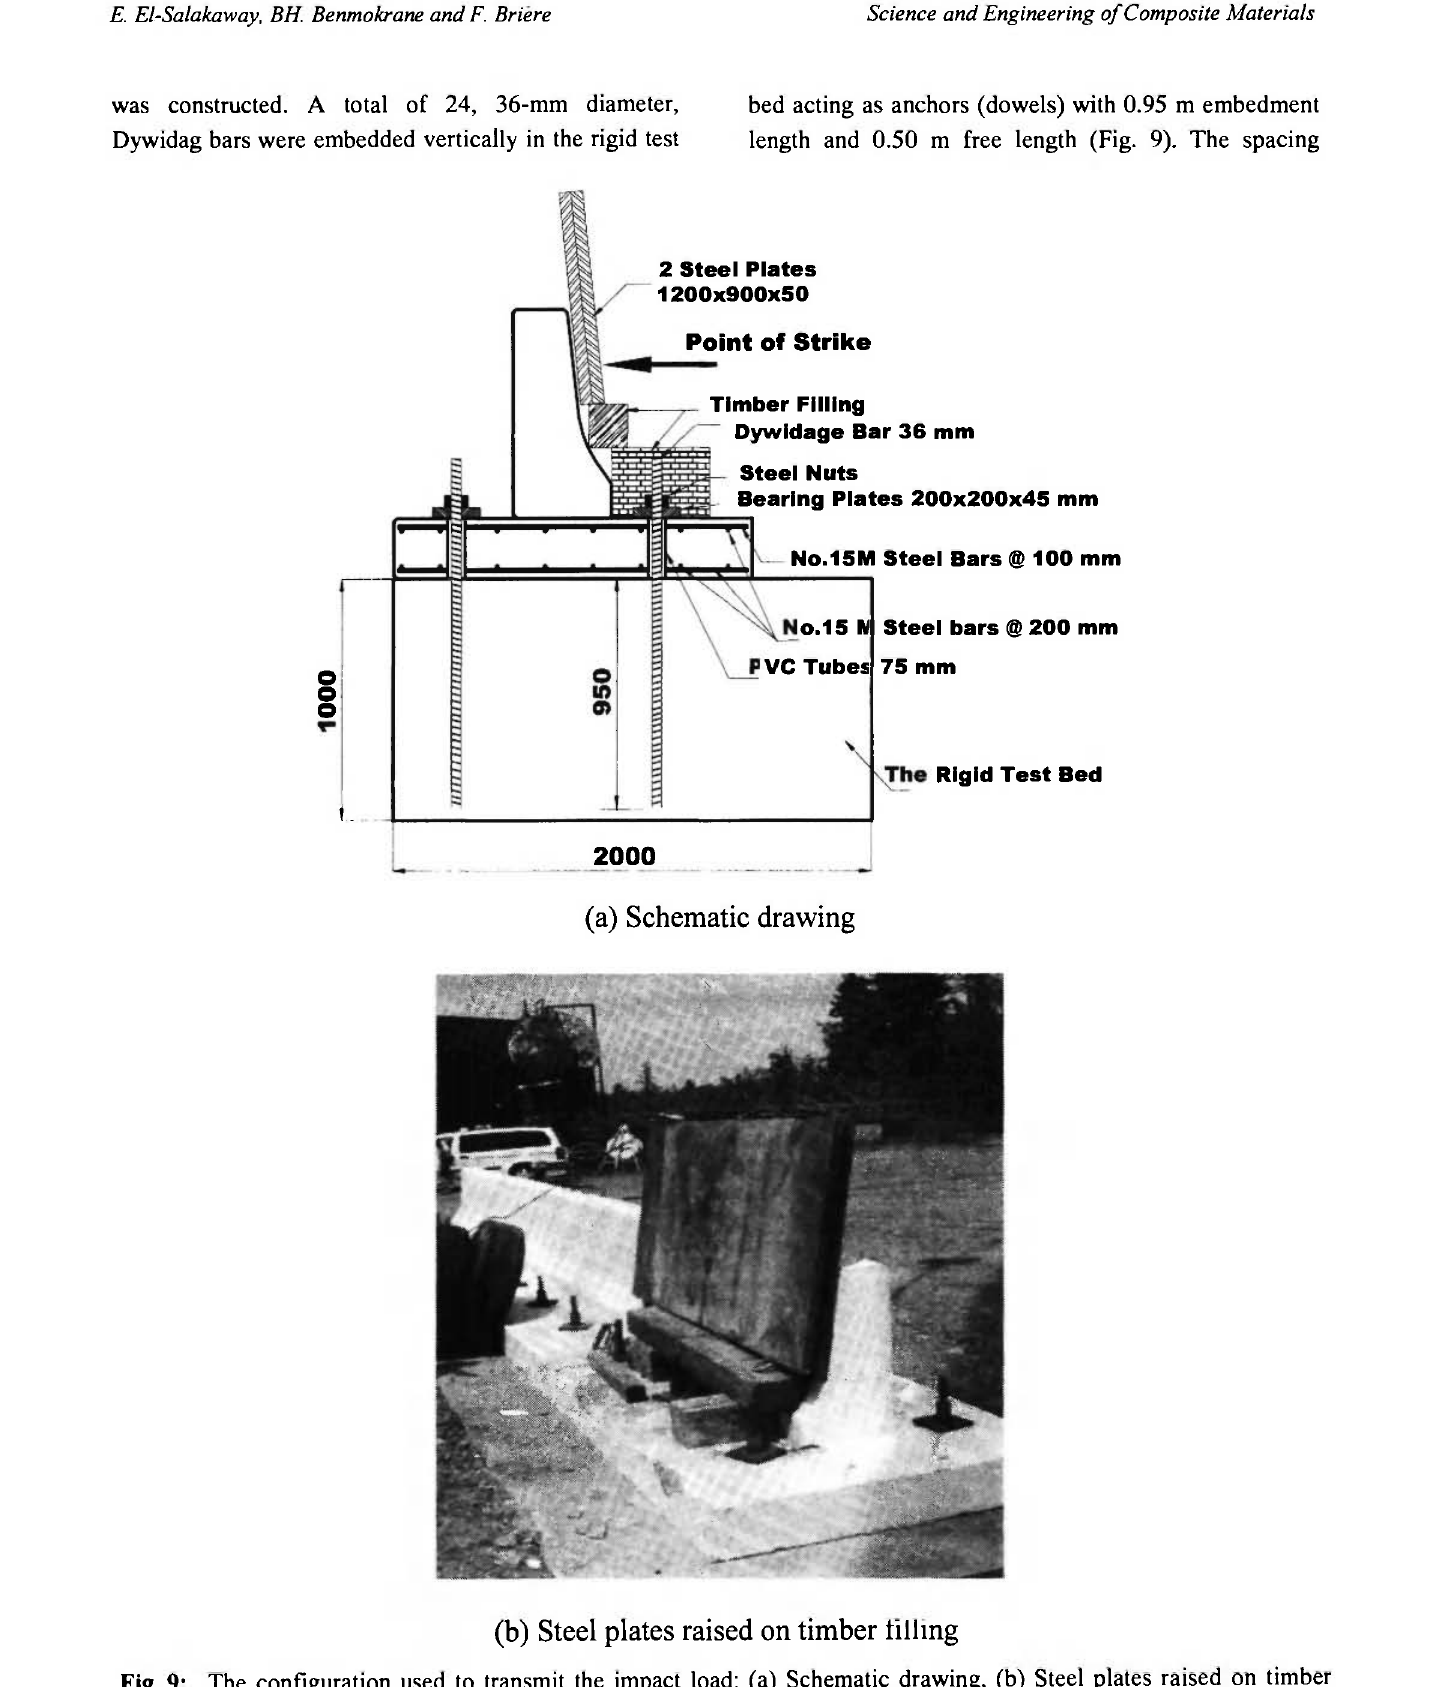
Fig. 9: The configuration used to transmit the impact load: (a) Schematic drawing, (b) Steel plates raised on timber